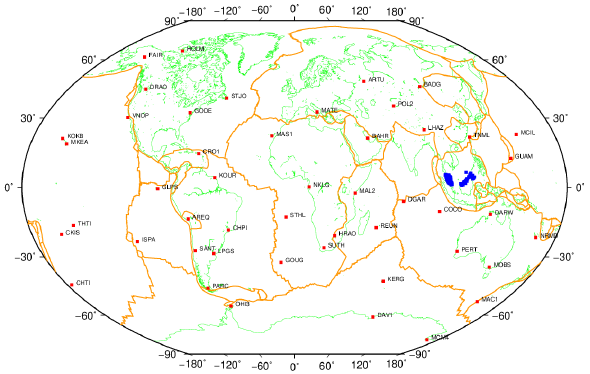
Fig. 3. Distribution of the processed stations where the red dots are the IGS14 Core